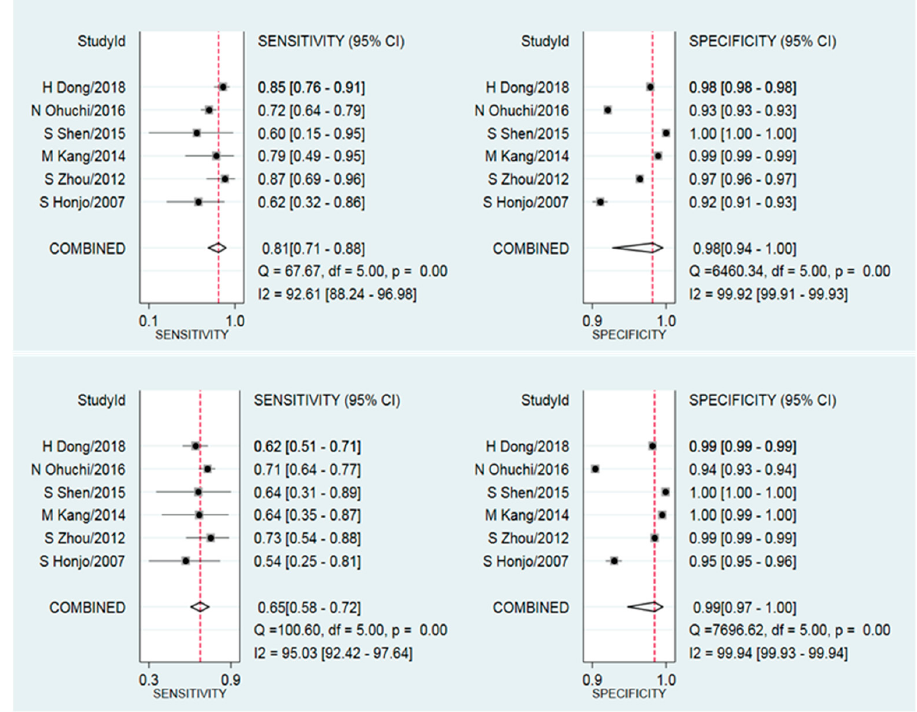
Figure 3. Forest plot of the sensitivity ( left ) and specificity ( right ) of mammography ( top ) and ultrasound ( bottom ) breast cancer screening in Asian women.